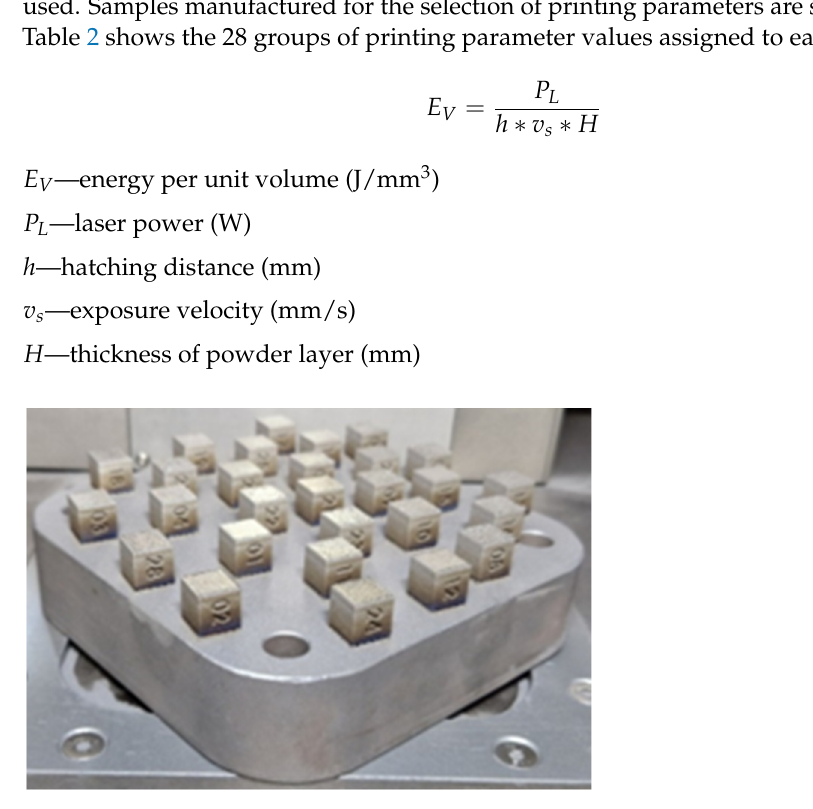
Figure 4. Samples fabricated to determine the most beneficial printing parameters. Table 2. Group of parameters used in the specimen manufacturing